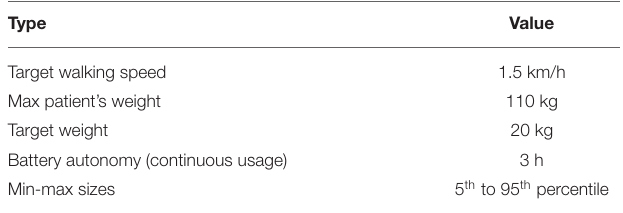
TABLE 3 | User-driven specifications of the TWIN